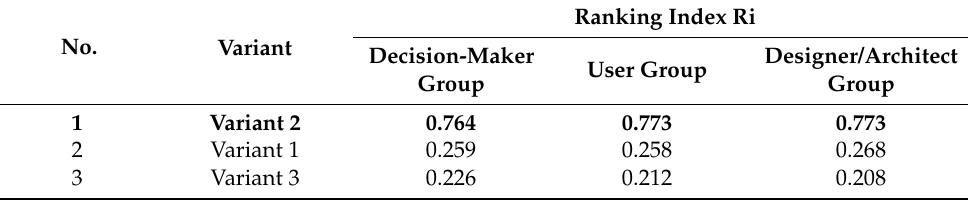
Table 14. Final ranking of